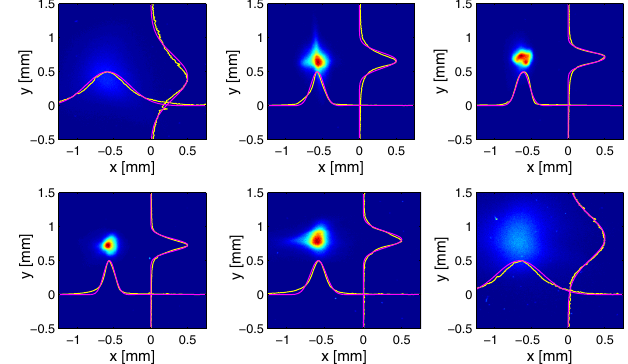
FIG. 7. Six out of the sixteen transverse beam images of a projected emittance measurement at 200 pC. The horizontal and vertical phase advances between each of the distributions are 30 degrees. The yellow lines are the projections to the horizontal and vertical axes and the magenta lines correspond to the Gaussian